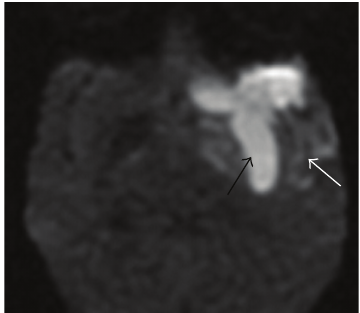
Figure 5: 0h DWI shows high-signal ischemic lesion in basal ganglion (black arrow) and temporal lobe (white arrow).